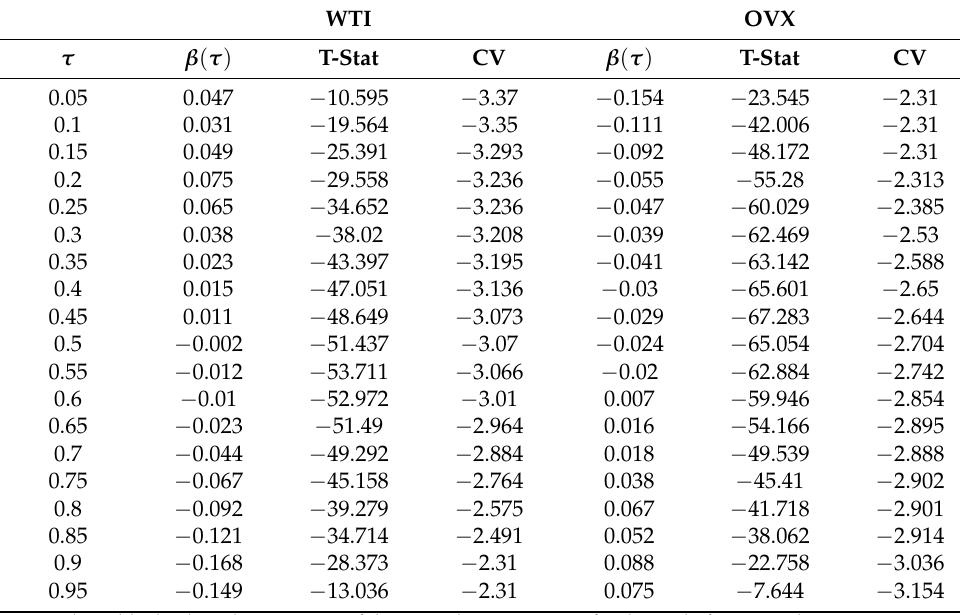
Table 4. Quantile autoregression unit root test results.